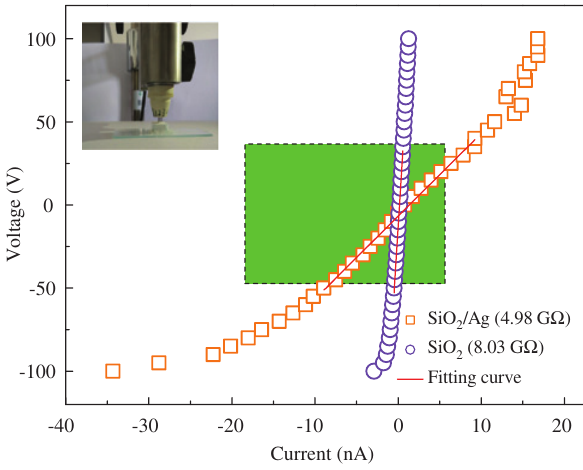
powder and SiO 2